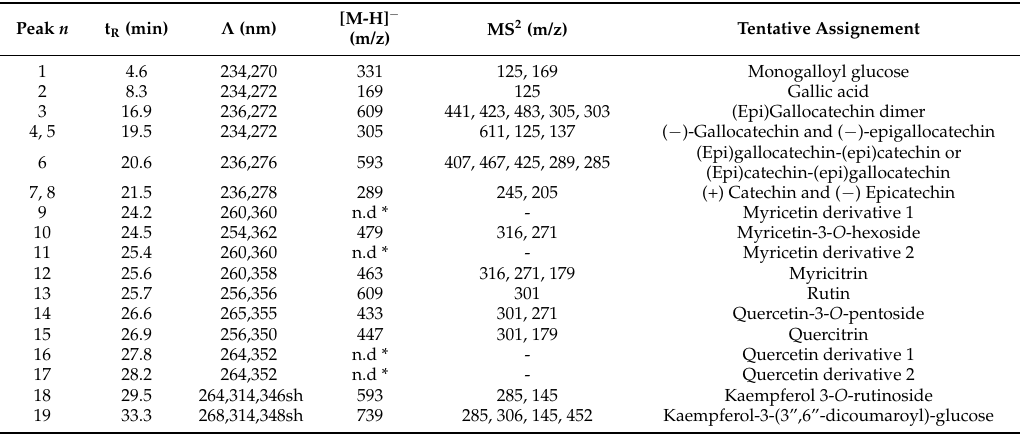
Figure 1. Chromatographic profile of crude ethanolic leaf extract (CEE) of leaves of Cistus incanus acquired by HPLC–DAD detected at the relative maxima of absorbance of proanthocyanins (280 nm) and flavonols (350 nm), respectively. Chromatographic conditions are given in the Materials and Methods section. For compound identification see Table 1. Table 1. HPLC–DAD-MS/MS characterisation of main polyphenols present in crude ethanolic leaf extract (CEE) of C. incanus . Compounds numbers correspond to those indicated in Figure 1. (n.d *, not detected; sh, shoulder).